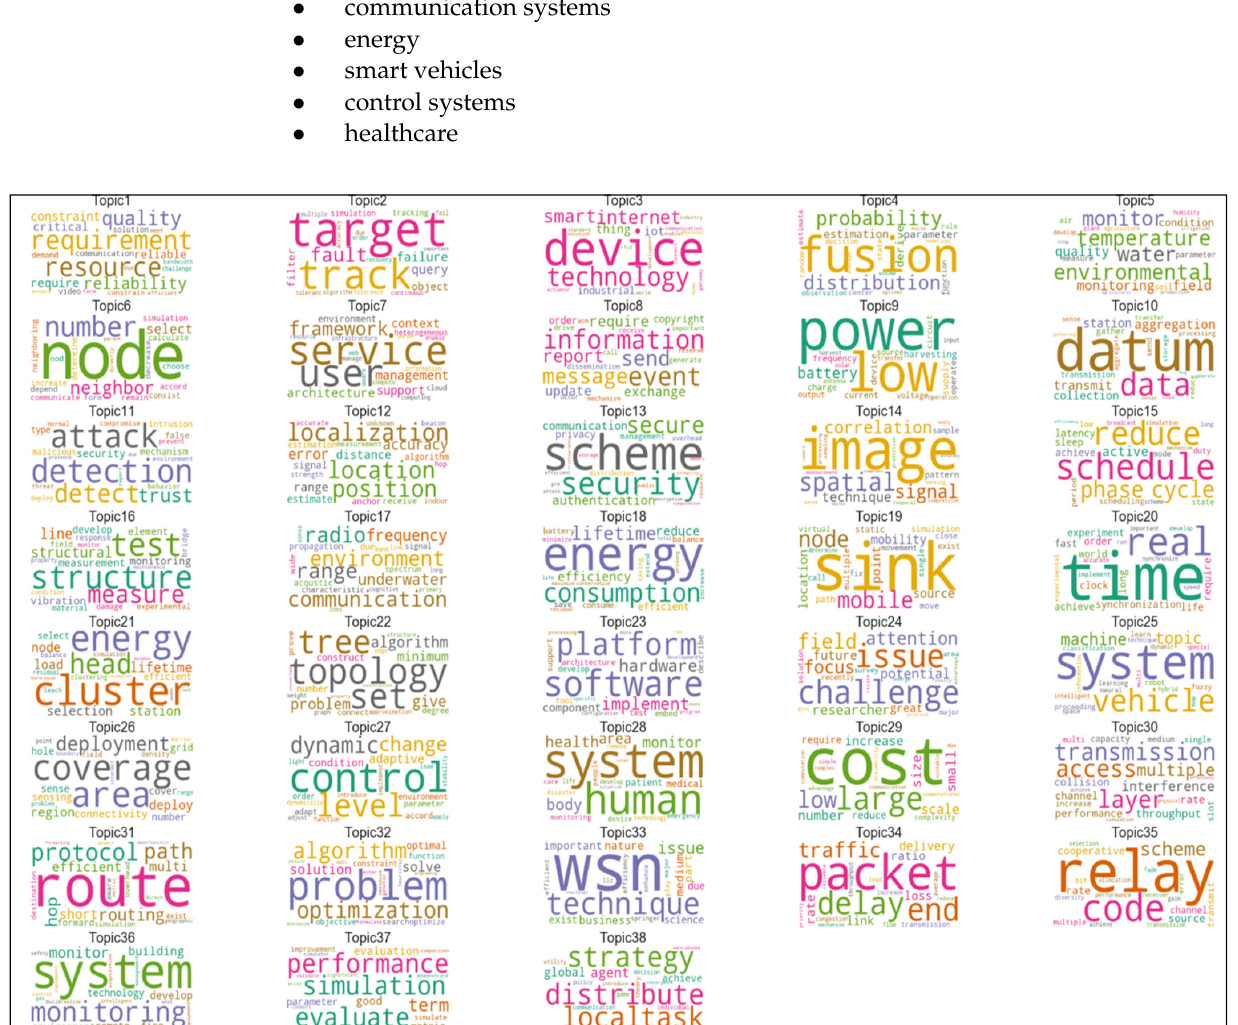
Table 4. Dynamics of trends in wireless sensor networks using trend analysis. Number of Topics